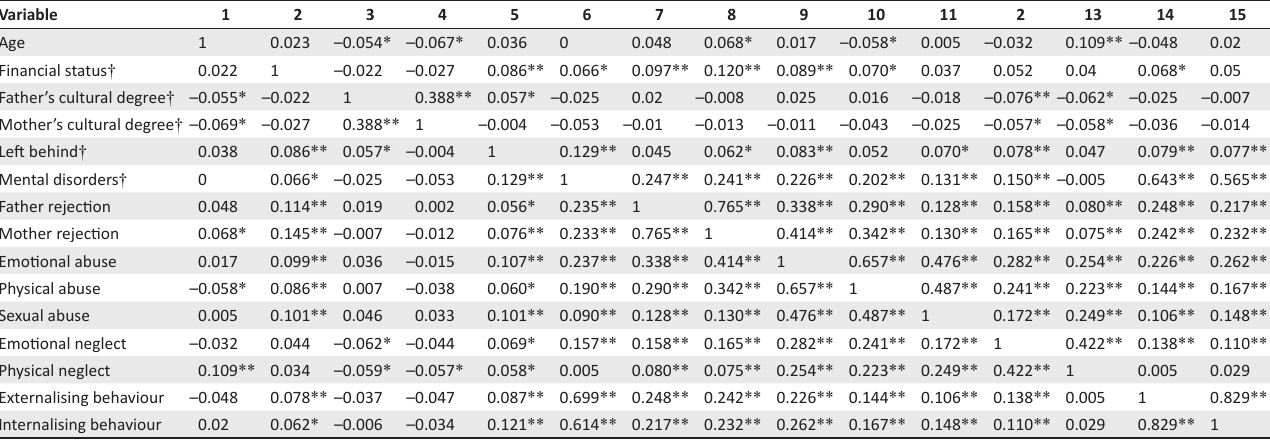
TABLE 2: Correlation coefficients for all variables of interest in the male sample ( n = 1305).